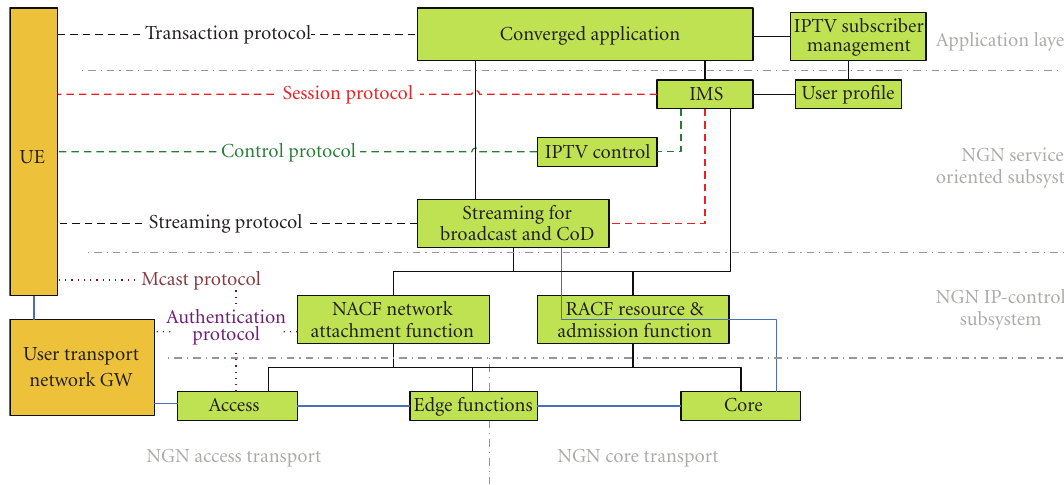
Figure 1: ITU-T concept of Converged NGN-based IPTV architecture [1].